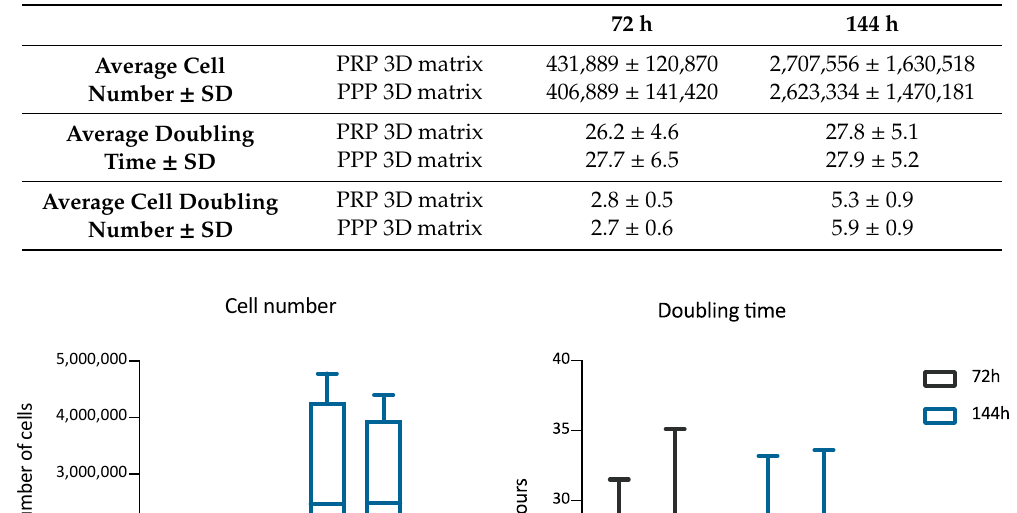
Table 2. Average cell number, doubling time and cell doubling number obtained at di ff erent time points (72, 144 h) from ADMSCs cultured inside a 3D fibrin-based matrix prepared from PRP or PPP (n = 3).